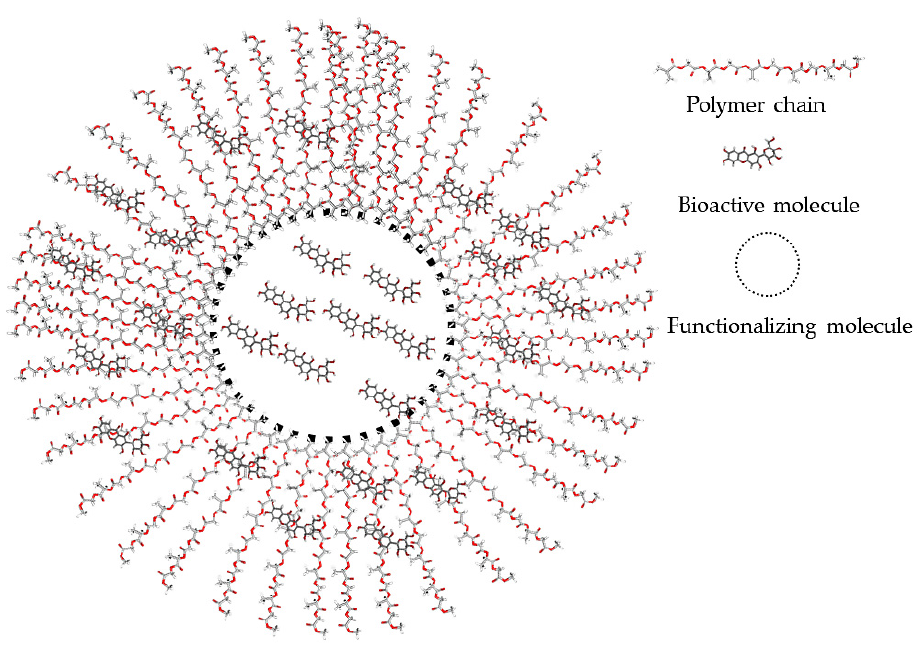
Figure 2. Hypothetical structure of nanoparticles [25].